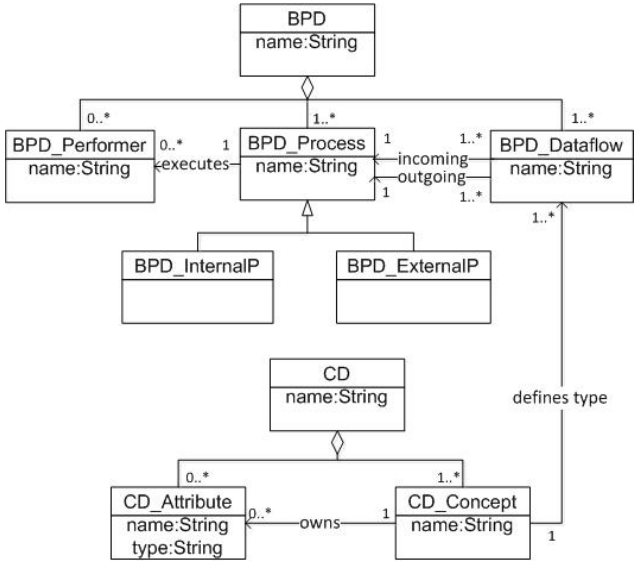
Fig. 3. Metamodel of the two-hemisphere model implemented in